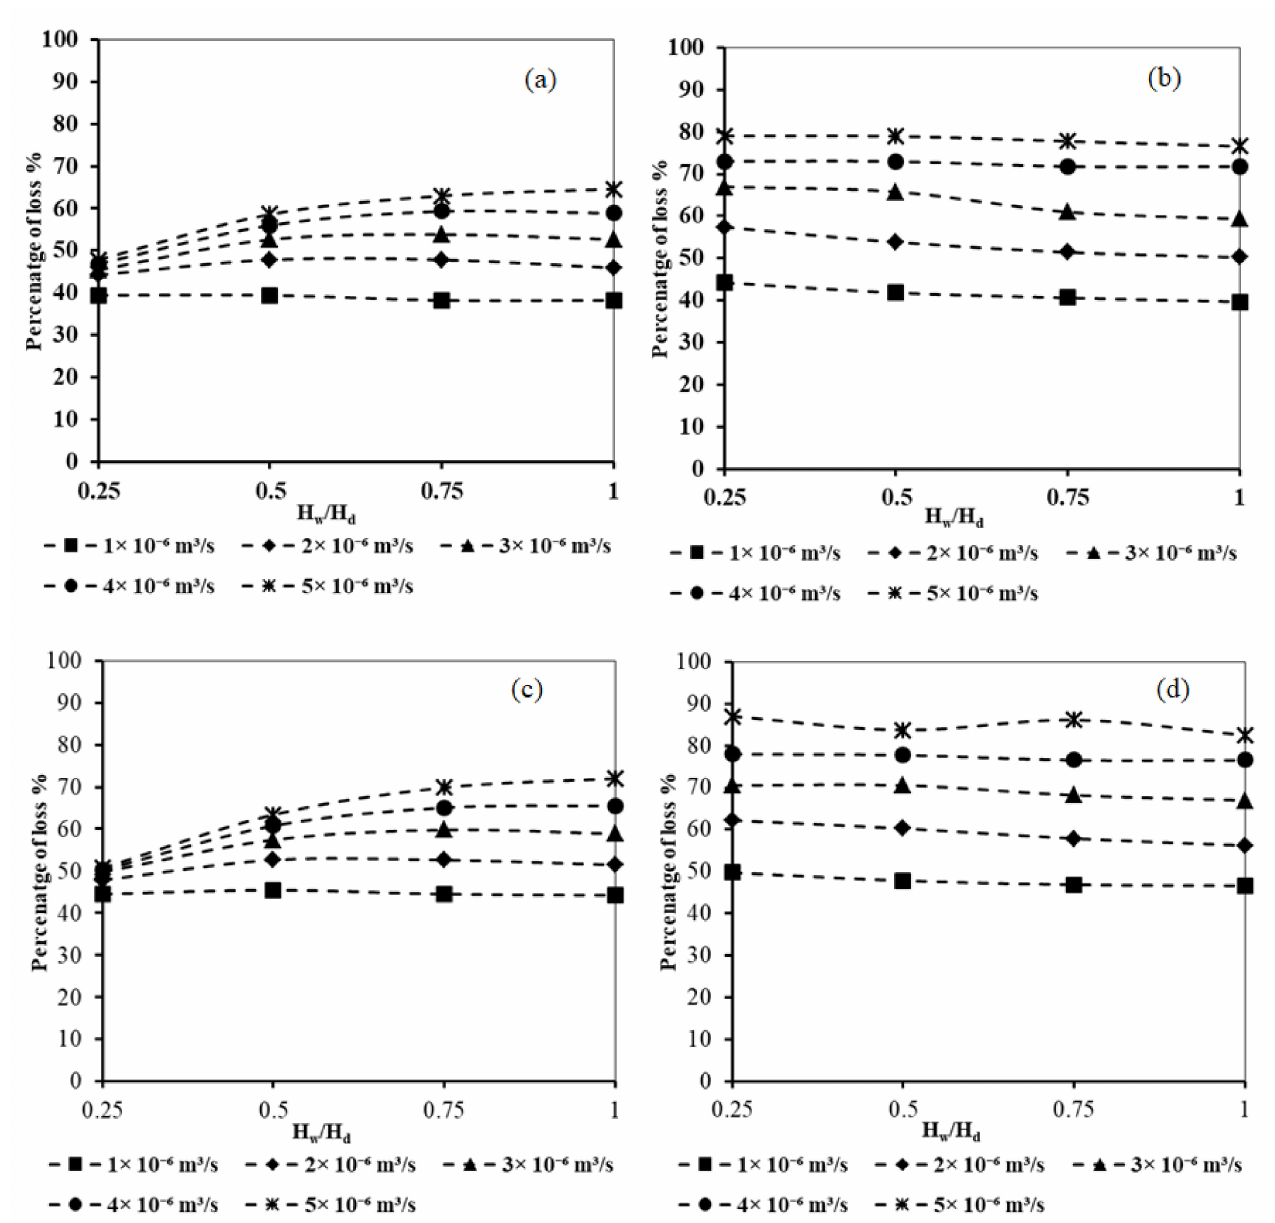
Figure 10. Relation between well location ratio and loss of subsurface dam effectiveness for L d = 0.30 m and H f = 0.2 m for: ( a ) L w /L d = 1.0 and D F = 0.005 m, ( b ) L w /L d = 2.0 and D F = 0.005 m, ( c ) L w /L d = 1.0 and D F = 0.01 m, (d) L w /L d = 2.0 and D F = 0.01